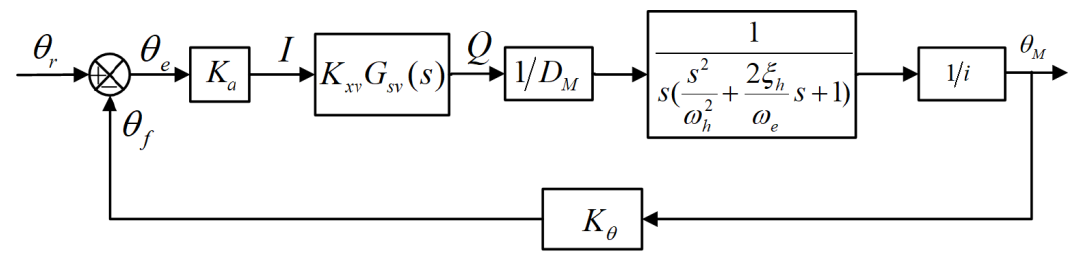
Figure 8. The angle control block diagram of the heading angle adjustment circuit.